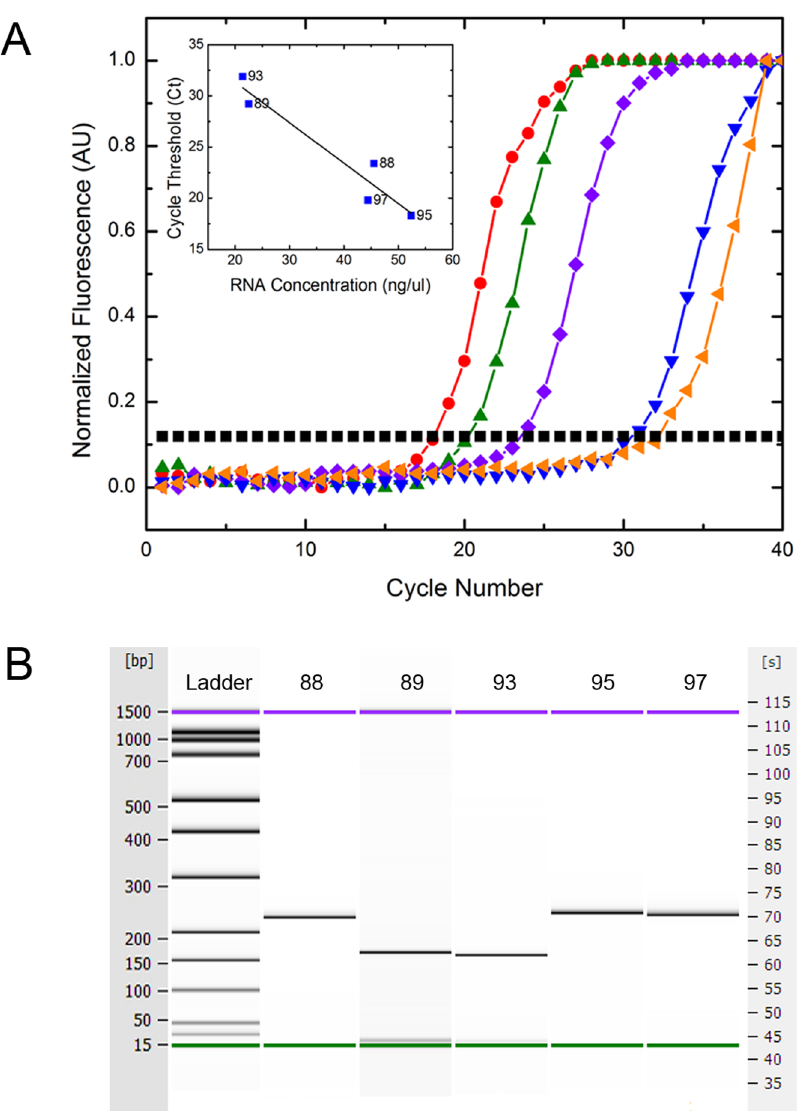
Figure 3. rtRT-PCR results for clinical samples. a: Samples 88, 89, 93, 95 and 97. Displays normalized fluorescence vs. cycle number of 5 clinical positive samples. Of the samples, 89 and 93 were H1p positive and samples 95, 97 and 88 were H3 positive when amplified with those respective primer sets. There was no cross-reactivity with the other primer sets and a NTC displayed no change in fluorescence over time. Legend: 95 (red (green m ), 88 (purple ¤ ), 89 (blue . ), 93 (orange b ), threshold (black & ). inset: Plot of the calculated cycle threshold vs. total RNA concentration following extraction from clinical samples. The linear regression fit of the Ct values is shown by the solid black line with an R 2 =.956. b: Generated gel plot for samples 88, 89, 93, 95 and 97. Displays the electrophoresis gel image from the Agilent Bioanalyzer 2100 and displays the 235 base pair (bp) amplicon for samples 88, 95 and 97 indicative of the H3 subtype and displays the 167 bp amplicon for samples 89 and 93 indicative of the H1p